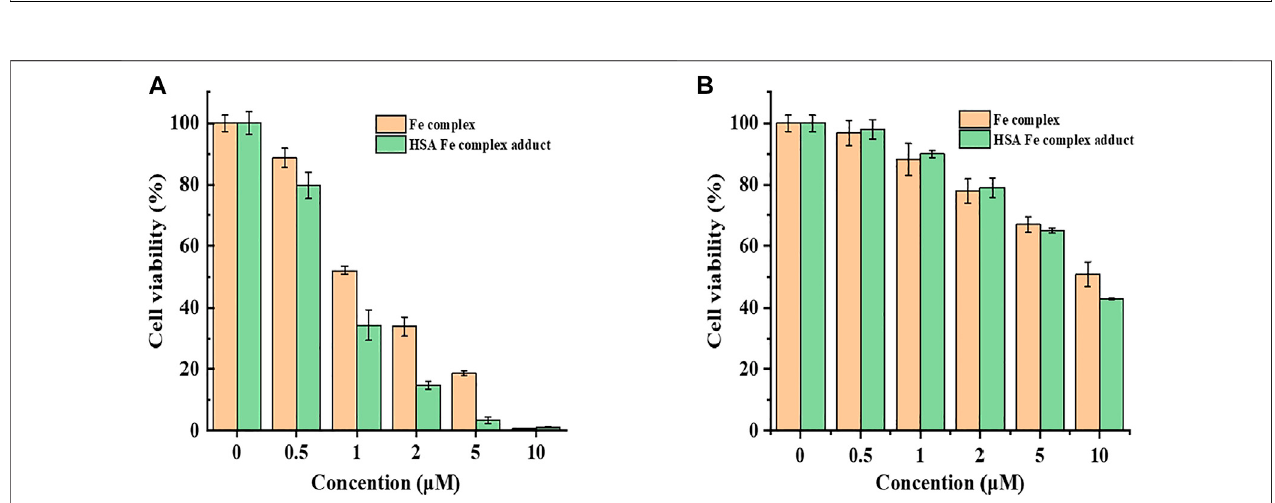
FIGURE7| CellviabilityoftheFecomplexandHSAFecomplexadductonHepG2cellswithCCK-8 (A) .ComparisonofthecytotoxicityoftheFecomplexwiththat of HSA Fe complex adduct on cell HL7702 (B) .